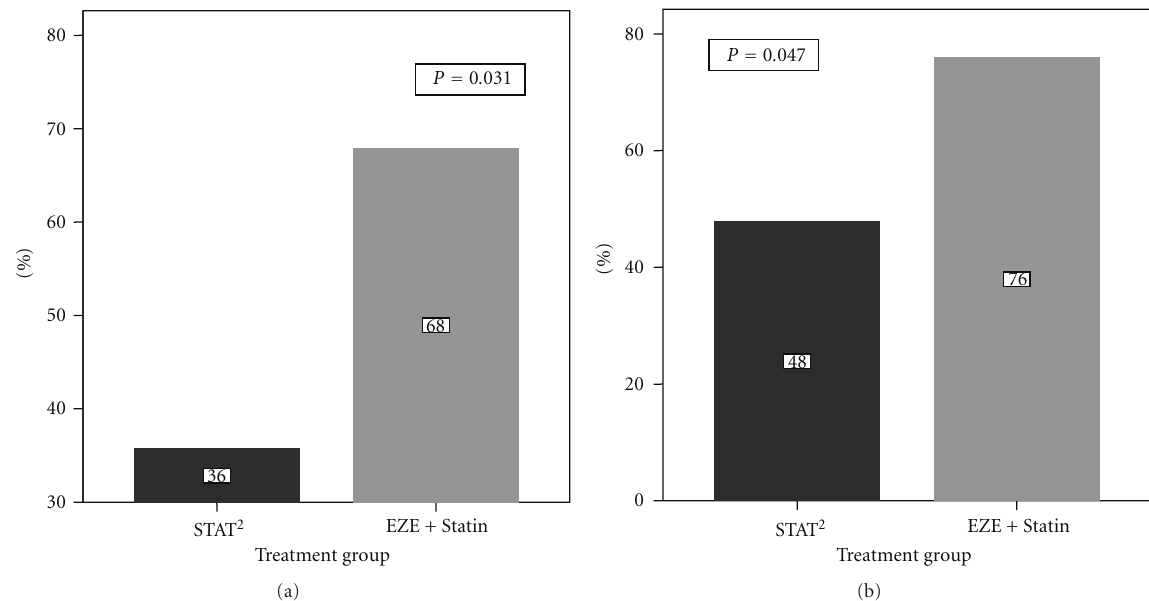
Figure 3: (a) Primary endpoint: percentage of patients achieving target LDL-C ( < 2.0mmol/L) at 6 weeks (b) Percentage of patients achieving target LDL-C ( < 2.0mmol/L) at 12